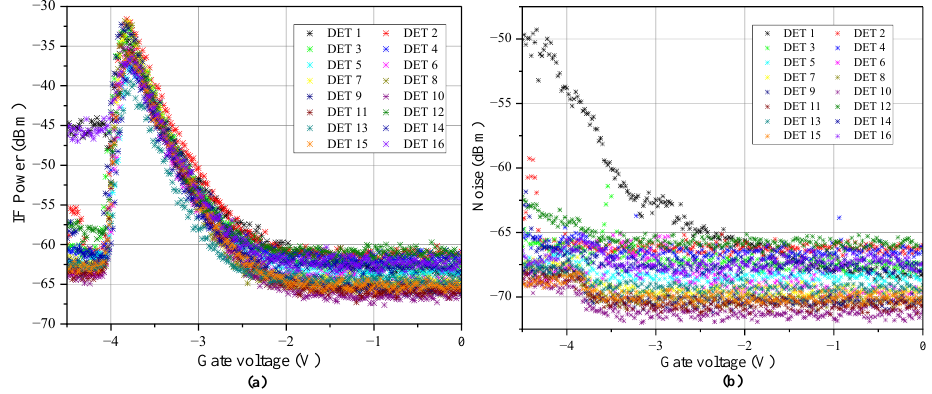
Figure 18. ( a ) IF signal and ( b ) noise power at IF frequency of 1.6 MHz, LO frequency of 331.52